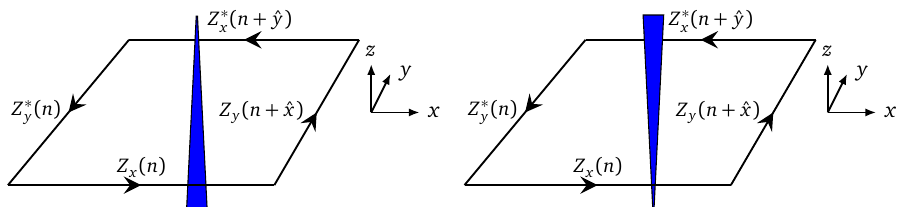
Figure 1: Illustrating nontrivial centre charge via a jet. (left) An m = + 1 vortex with centre charge z = exp ( 2 π i / 3 ) is rendered as a jet pointing in the + ˆ z direction. (right) An m = − 1 vortex with centre charge z = exp ( − 2 π i / 3 ) is rendered as a jet in the − ˆ z